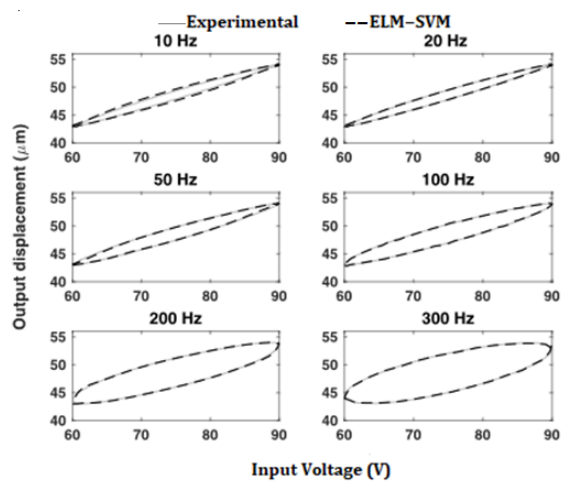
Figure 12. Comparison of PZT actuator results from ELM − SVM model with experimental data results for different frequency responses.